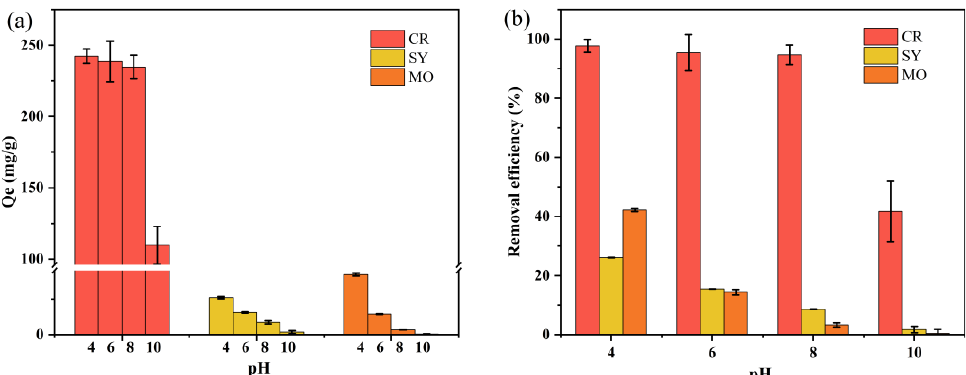
Figure 8. The effects of initial solution pH on adsorption capacity ( a ) and removal efficiency ( b ) of PDA/PEI-TPU NFMs toward CR, SY and MO (dyes concentration: 100 mg/L).